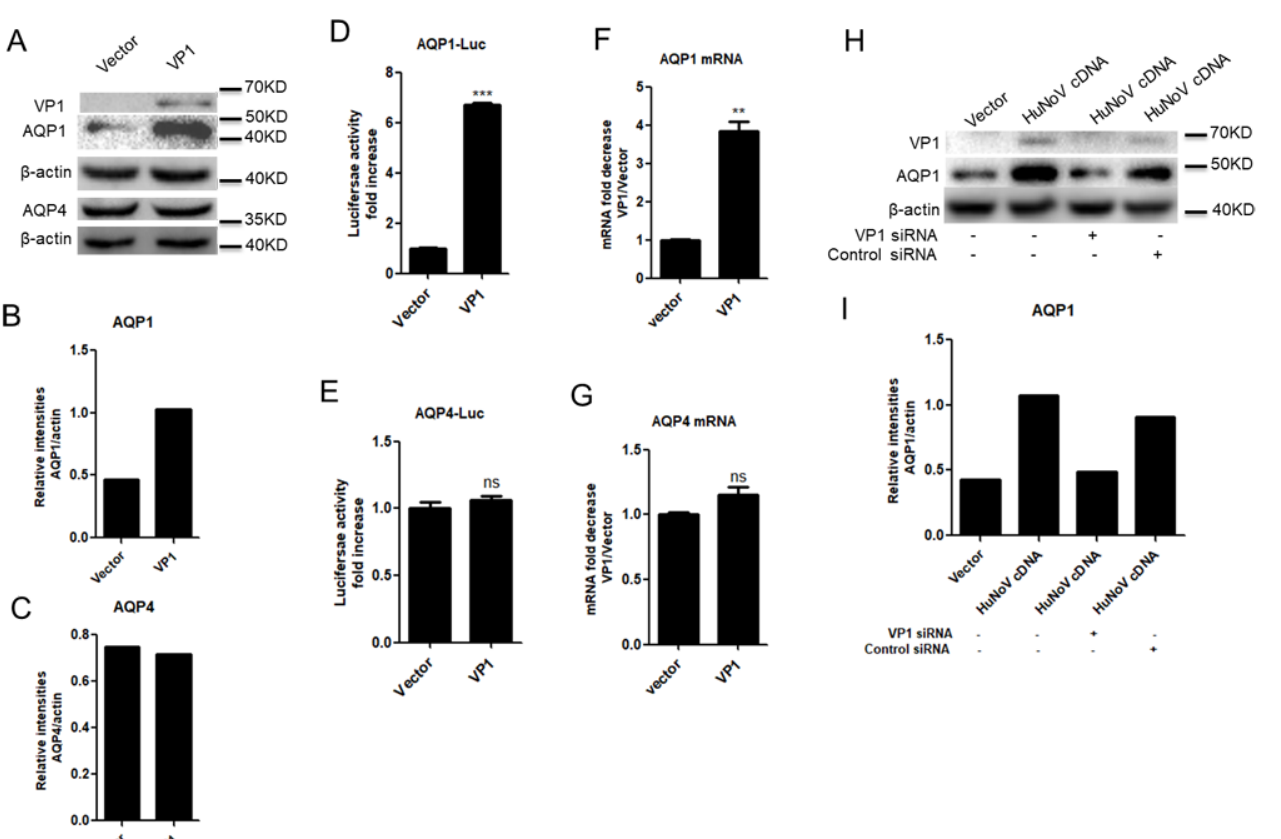
Figure 3. HuNoV VP1 promotes the expression of AQP1. ( A – C ). VP1 promoted the production of AQP1. ( D , E ). VP1 promoted the activation of AQP1 promoter. Caco2 cells were co-transfected with empty vector or VP1-expressing plasmid and AQP1-Luc or AQP4-Luc for 24 h. Cells were lysed and detected for the activity of Firefly luciferase. ( F , G ). VP1 promoted the transcription of AQP1. Caco2 cells were transfected with empty vector or VP1-expressing plasmid for 24 h ( A , F , G ). The protein levels of AQP1 and VP1 were measured by WB ( A ) and quantified using Image J ( B , C ). The transcription of AQP1 and AQP4 was evaluated by relative real-time quantitative PCR ( F , G ). AQP1 and AQP4 mRNA copies were normalized using GAPDH and expressed as fold increase in the value for the empty vector. ( H , I ). VP1 knockdown impaired HuNoV-induced AQP1 expression. Caco2 cells were transfected with VP1 specific siRNA for 4 h followed by transfection with full length HuNoV cDNA-expressing plasmid for another 24 h. The knockdown effect of VP1 siRNA and AQP1 expression were detected by WB ( H ). The relative intensities of AQP1 blots were quantified ( I ). For graphs, the data shown are mean ± S.D. of three independent experiments with each condition performed in triplicate. For images, one representative experiment out of three is shown. ** p < 0.01, *** p < 0.001, ns, not